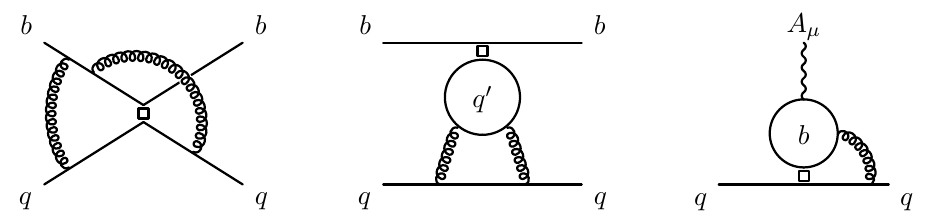
Figure 4 . Sample two-loop Feynman diagrams whose divergent parts contribute to the calculation of the two-loop anomalous dimensions involving bottom quarks. The empty squares symbolize the insertion of an effective operator. The diagrams of the kind shown in the middle panel, involving three different quark flavors, vanish due to the odd number of Dirac matrices in the trace. Diagrams of the kind shown in the right panel contain traces of Dirac matrices with γ 5 , which are treated in the Larin